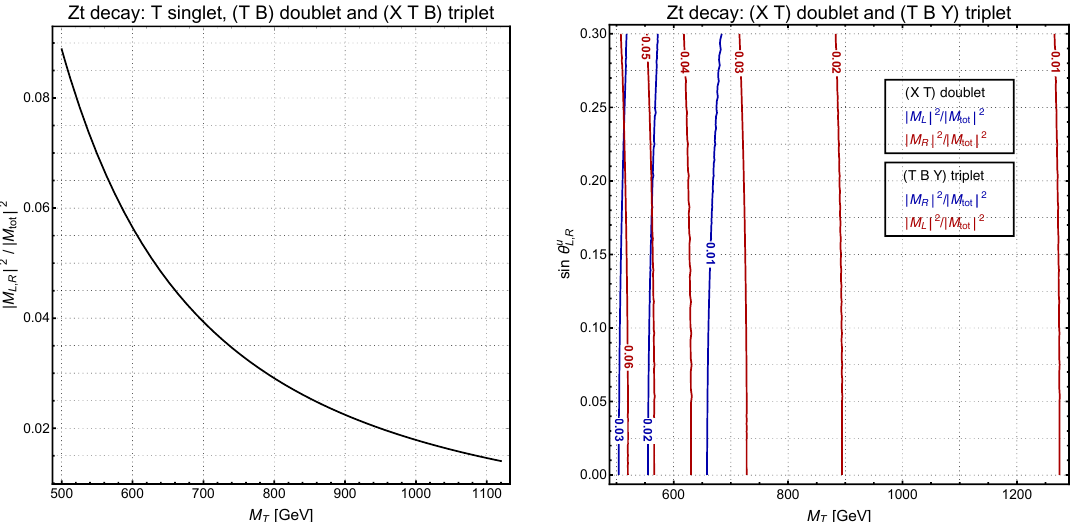
Figure 2 . Fraction of left-handed and right-handed polarised Z boson arising from the neutral current decay of a T VLQ. In the left panel the singlet, ( T B ) doublet and ( X T B ) triplet representations are shown as function of m T , while in the right panel the ( X B ) doublet and ( T B Y ) triplet representations are shown in the m T (cid:0) sin (cid:18) u plane. L;R